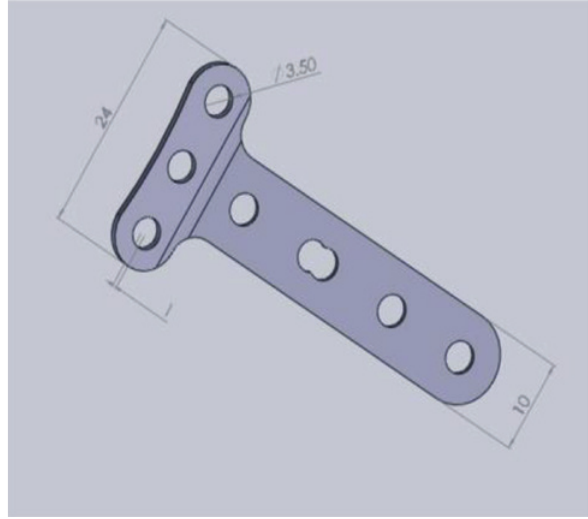
Figure 1: Bone fixation plate with a 3.5-mm screw.